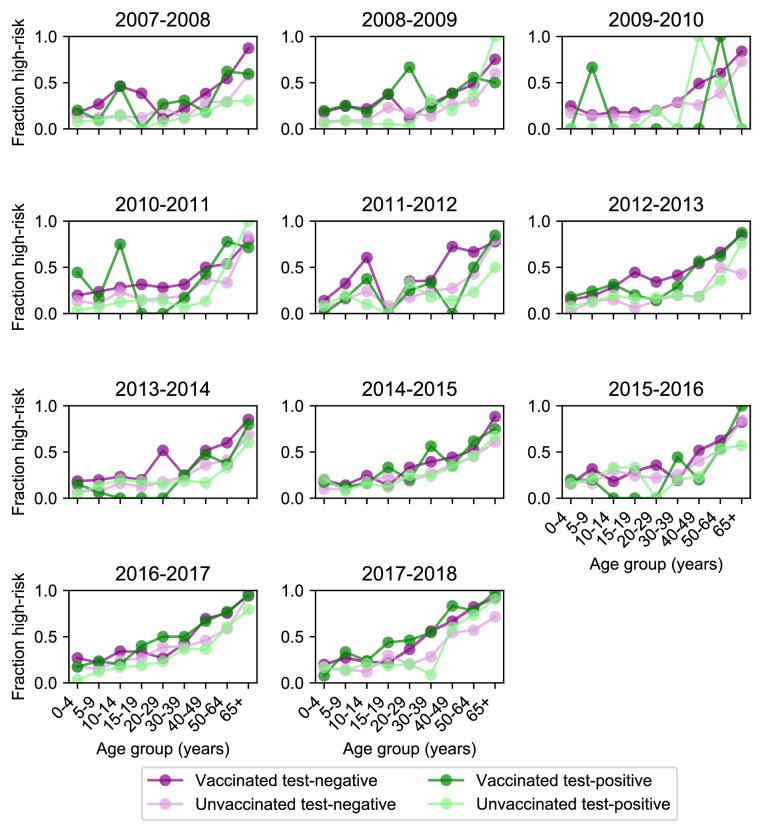
Age distribution of high-risk medical status.High-risk medical status (Materials and methods, ‘Study cohort’) varies with age and vaccination status but stays relatively consistent across seasons. Each plot shows the fraction of enrolled people who had a high-risk medical condition for each season stratified by age, vaccination status, and test status. High-risk medical condition data was not collected for the 2009 pandemic season.